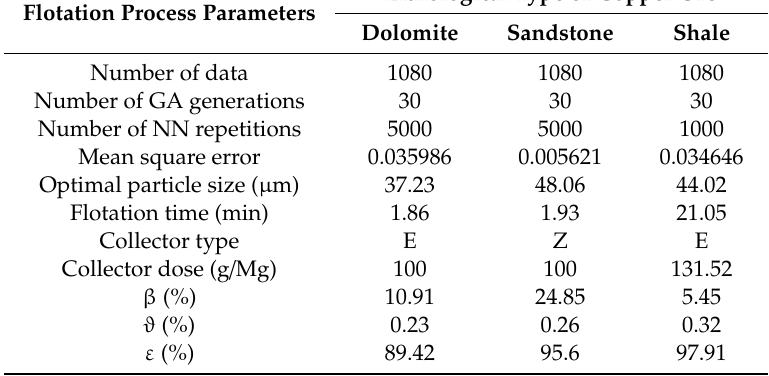
Table 12. A summary of the optimisation results of the flotation process of particular lithological types from the Lubin-Głog ó w copper ore district in the Denver-type flotation machine (E—aqueous solution of ethyl sodium xanthate, Z—aqueous solution of isobutyl sodium xanthate, GA—genetic algorithms, NN—neural network).